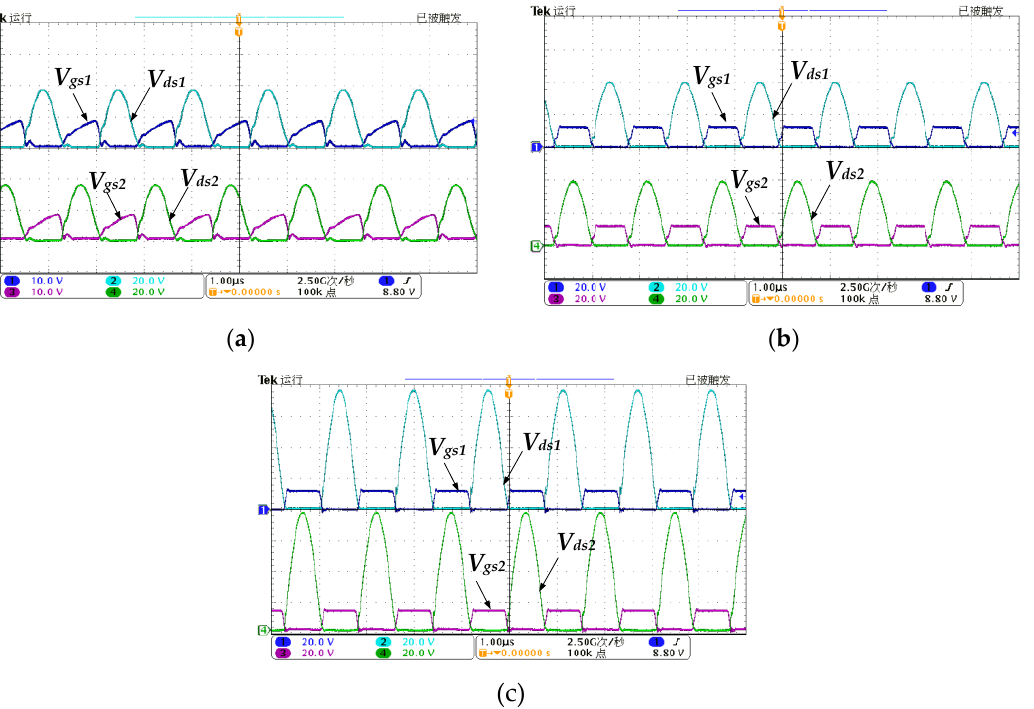
Figure 12. Gate and drain voltage waveforms of two MOSFETs (metal oxide silicon field effect transistors) at 6 cm: ( a ) traditional inverter at V DC = 12 V (Exp 1); ( b ) improved inverter at V DC = V drive = 12 V (Exp 2); ( c ) improved inverter at V DC = 24 V and V drive = 12 V (Exp 3).